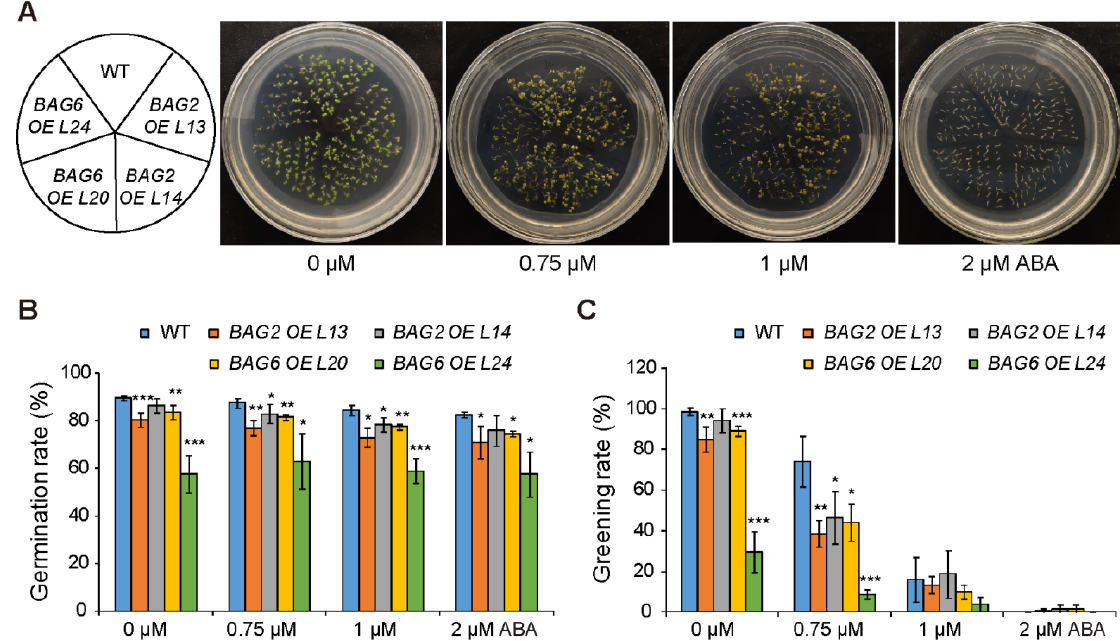
Figure 5. AtBAG2 and AtBAG6 overexpression lines are more sensitive to ABA than the WT. ( A – C ) Seed germination rate and greening rate of WT, AtBAG2 and AtBAG6 overexpression lines. Sterilized seeds were sowed on MS medium supplemented without or with different concentrations of ABA. The germination percentage and the greening rate were scored. Shown are means ± SD. * represent the significant differences at p < 0.05; ** represent p < 0.01; *** represent p < 0.001 (Student’s t -test).